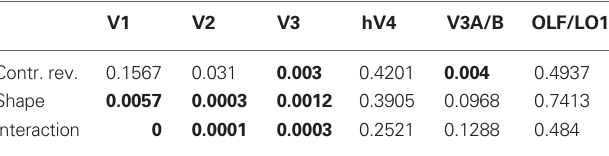
Table 2 | Summary of the results of the six independent ANOVAs